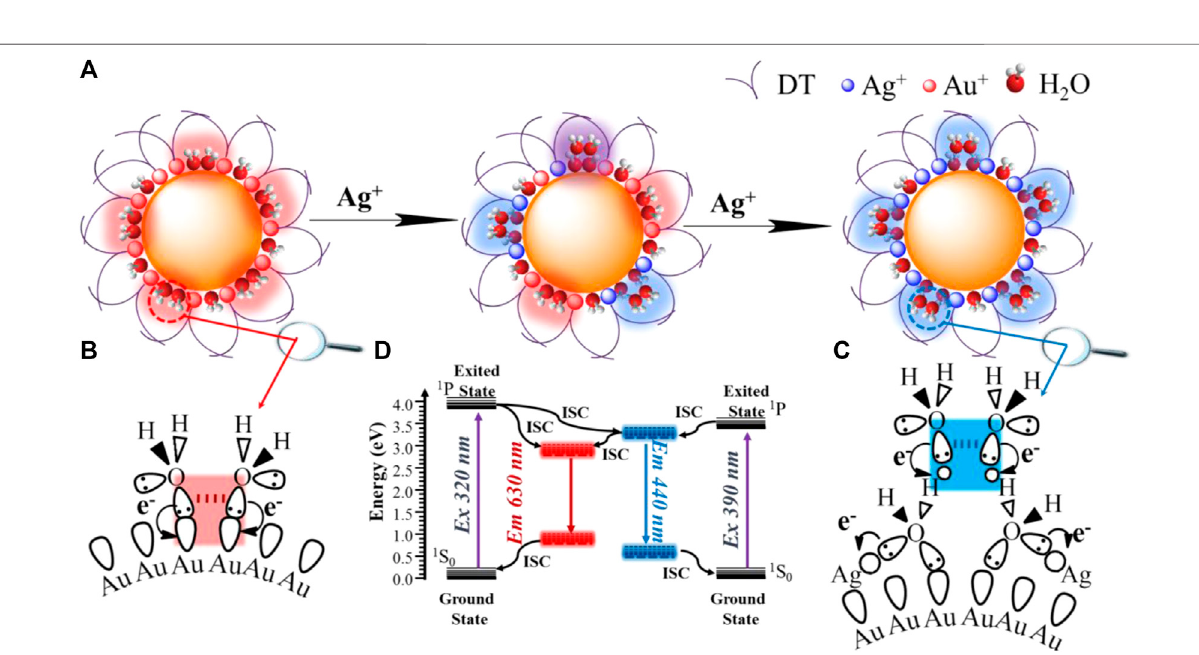
Frontiers in Chemistry |